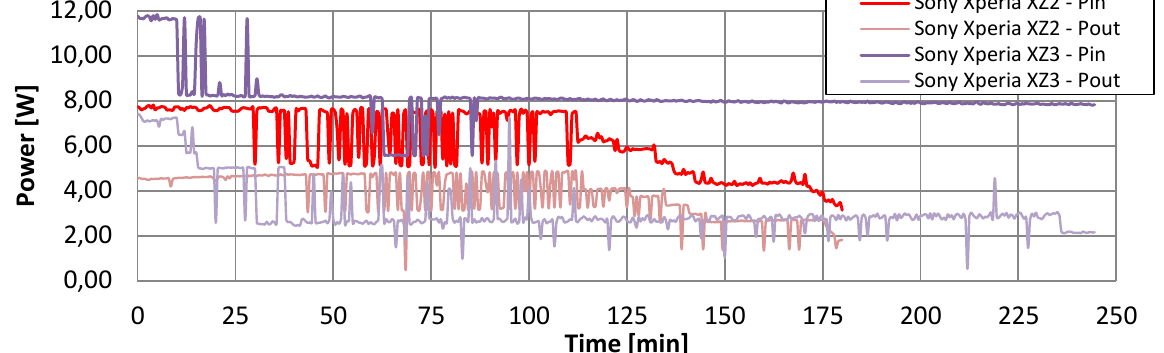
Fig. 2. Characteristics of input and output power for Quick Charge charging for selected smartphone models.